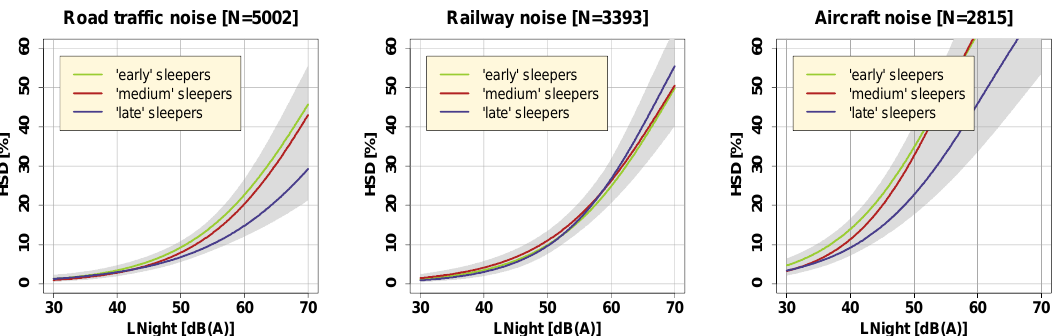
Figure 8. Exposure-response relationships for road traffic (left), railway (middle), and aircraft noise (right), for ‘early’, ‘medium’, and ‘late’ sleepers, including (overlapping) 95% confidence intervals (shaded areas). Curves are based on the adjusted model in the full sample with covariates centered on the mean.